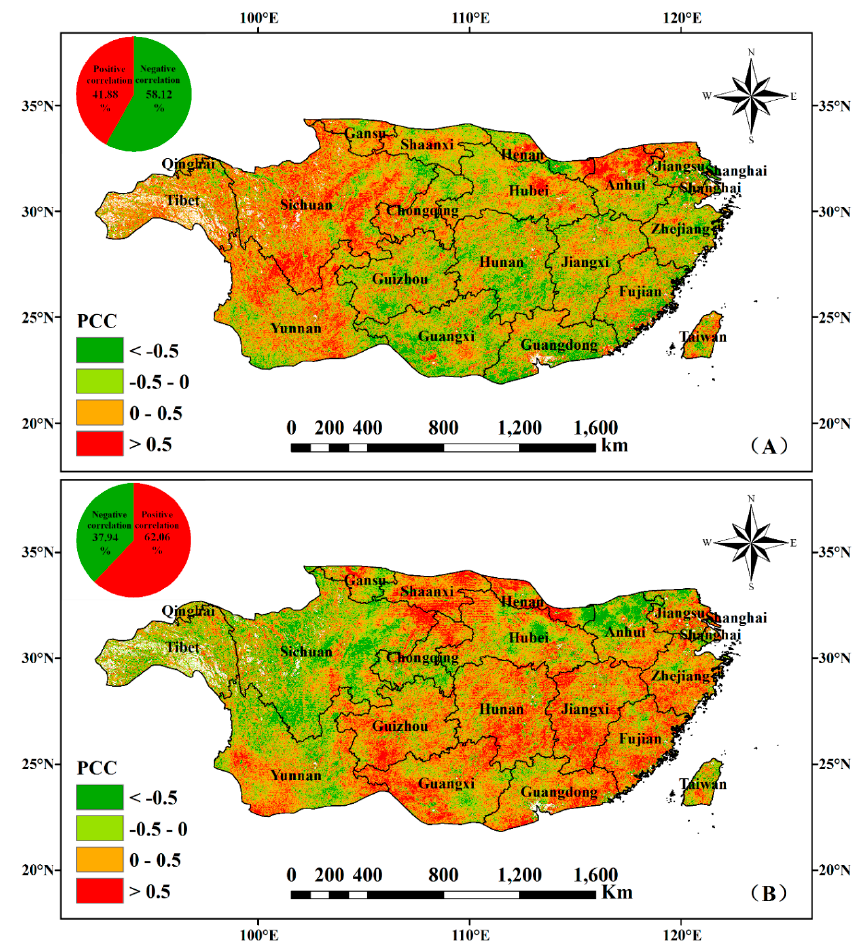
Figure 6. Spatial distribution of partial correlation coefficient (PCC) values between the subtropical FVC and ( A ) Tmax and ( B ) Tmin from 2001 to 2018. The spatial distribution of the PCC between the subtropical FVC and Tmin from 2001 to 2018 is shown in Figure 6B. Figure 6B shows that the PCC between the FVC and Tmin was distributed mostly between ‐ 0.30 and 0.52, with an average PCC of 0.09. The propor ‐ tion of the study area with a positive correlation between the FVC and Tmin was 62.06%, the proportion with a significant (P<0.05) positive correlation was 8.46%; the proportion with a negative correlation was 37.94%, and proportion with a significant (P<0.05) nega ‐ tive correlation was only 2.34%. This indicated that the influence of Tmin on the FVC in the subtropical region was mainly a positive correlation; this is, an increase in Tmin pro ‐ motes vegetative growth and development in most areas of the subtropical region, result ‐ ing in an increase in the FVC. Comparing and analyzing Figure 6A and Figure 6B reveals that the partial correla ‐ tions between the subtropical FVC and Tmin and Tmax showed opposite spatial distribu ‐ tion patterns. Among them, the partial correlation between the FVC and Tmin in the cen ‐ tral and eastern regions was greater than that in the western region, and the partial